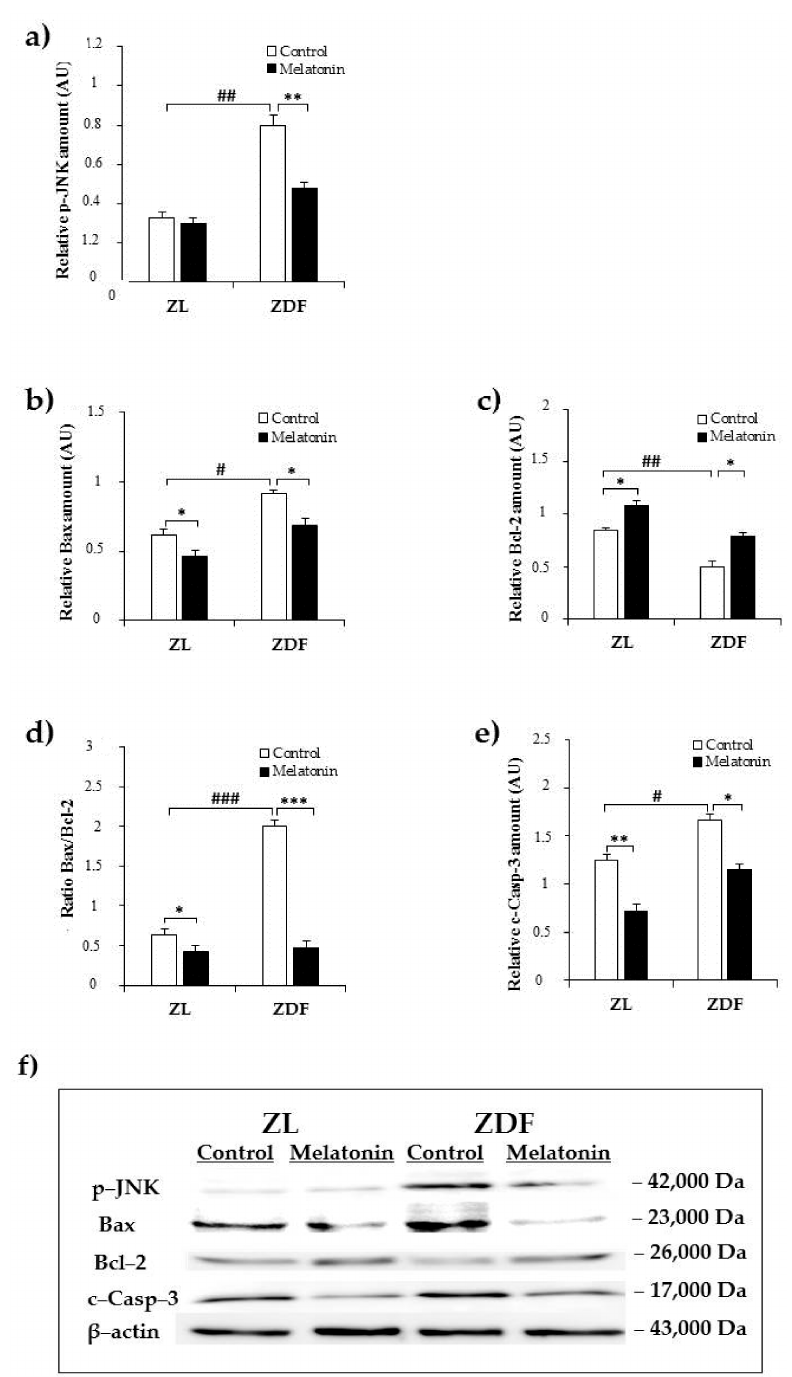
Figure 2. Effects of melatonin supplementation on ER stress-related apoptotic markers in the kidney of Zücker lean and diabetic fatty rats as measured by Western blot. ( a – c , e ) Densitometry quantifica- tion of p–c–jun amino terminal kinase (JNK), Bax, B cell lymphoma (Bcl)-2, and cleaved caspase-3 protein levels. ( d ) Bax/Bcl-2 ratio expression. ( f ) Representative blot of phospho–JNK, Bax, Bcl-2, and cleaved caspase-3. C–ZL: control lean rats without melatonin; M–ZL: lean rats with melatonin; C–ZDF: control diabetic fatty rats without melatonin; M–ZDF: diabetic fatty rats with melatonin; ZL: Zücker lean rats; ZDF: Zücker diabetic fatty rats. Values are means ± S.E.M ( n = 3) of ratios of specific protein levels to β –actin (Loading protein). # p < 0.05, ## p < 0.01, ### p < 0.001 C–ZDF vs. C–ZL; * p < 0.05, ** p < 0.01 M–ZL vs. C–ZL; *** p < 0.001 M–ZL vs. C–ZL; * p < 0.05, *** p < 0.001 M–ZDF vs. C–ZDF (Tukey post hoc